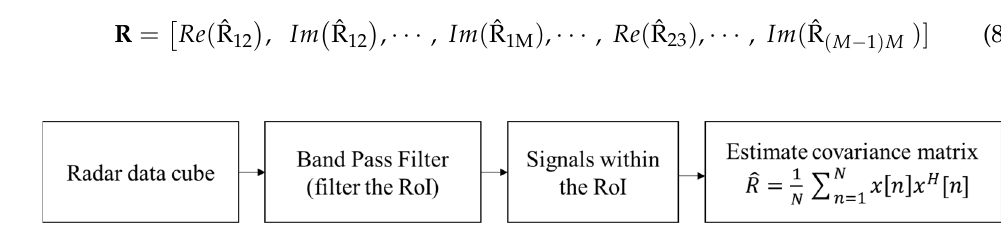
Figure 3. The covariance matrix of